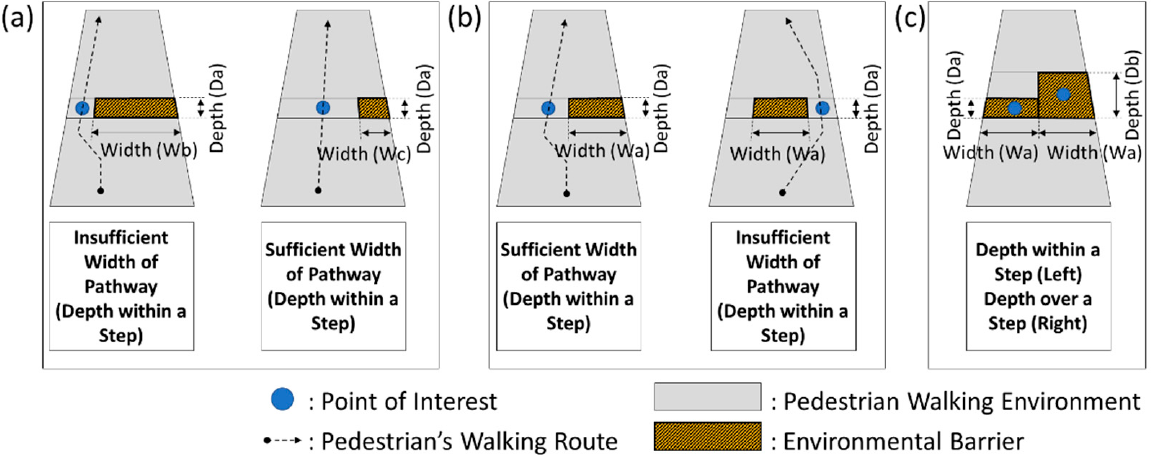
Figure 9. Comparison of Effects by Size and Location of Environmental Barriers: ( a ) Comparison of Location of Environmental Barrier; ( b ) Comparison of Width of Environmental Barrier; and ( c ) Comparison of Depth of Environmental Barrier.